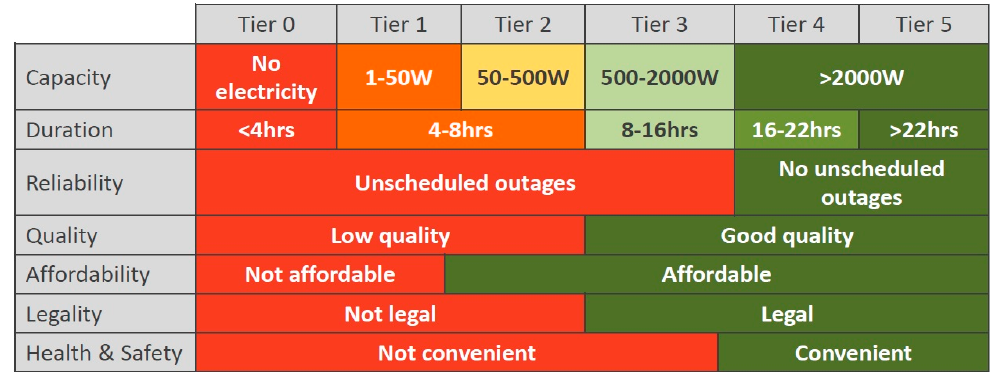
Figure 2. Quality of Power Supply for different Energy Access Tiers – provided by ESMAP.